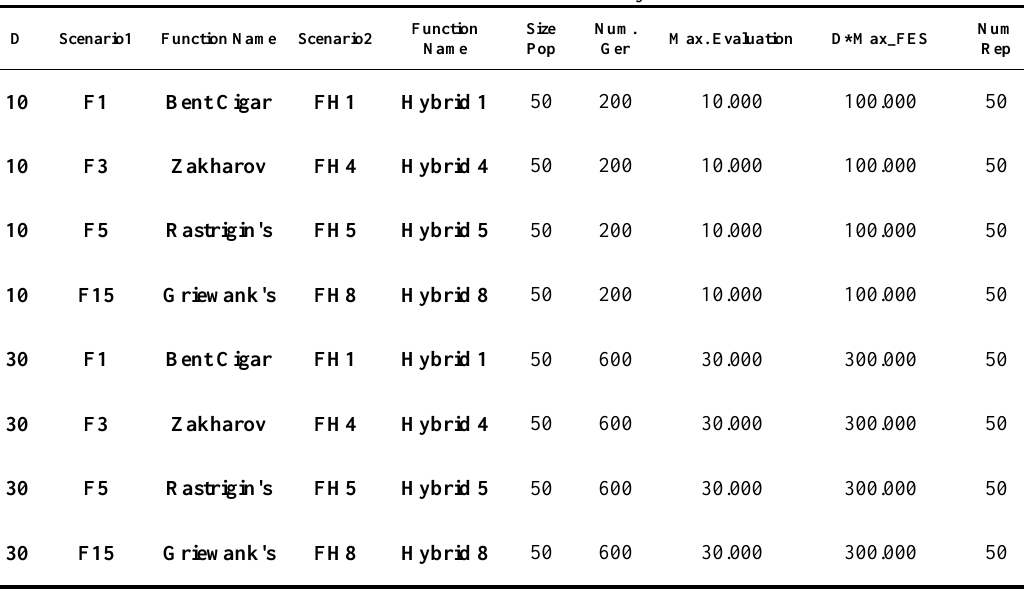
Table 3: Scenario 1 and 2 - Basic and Hybrid